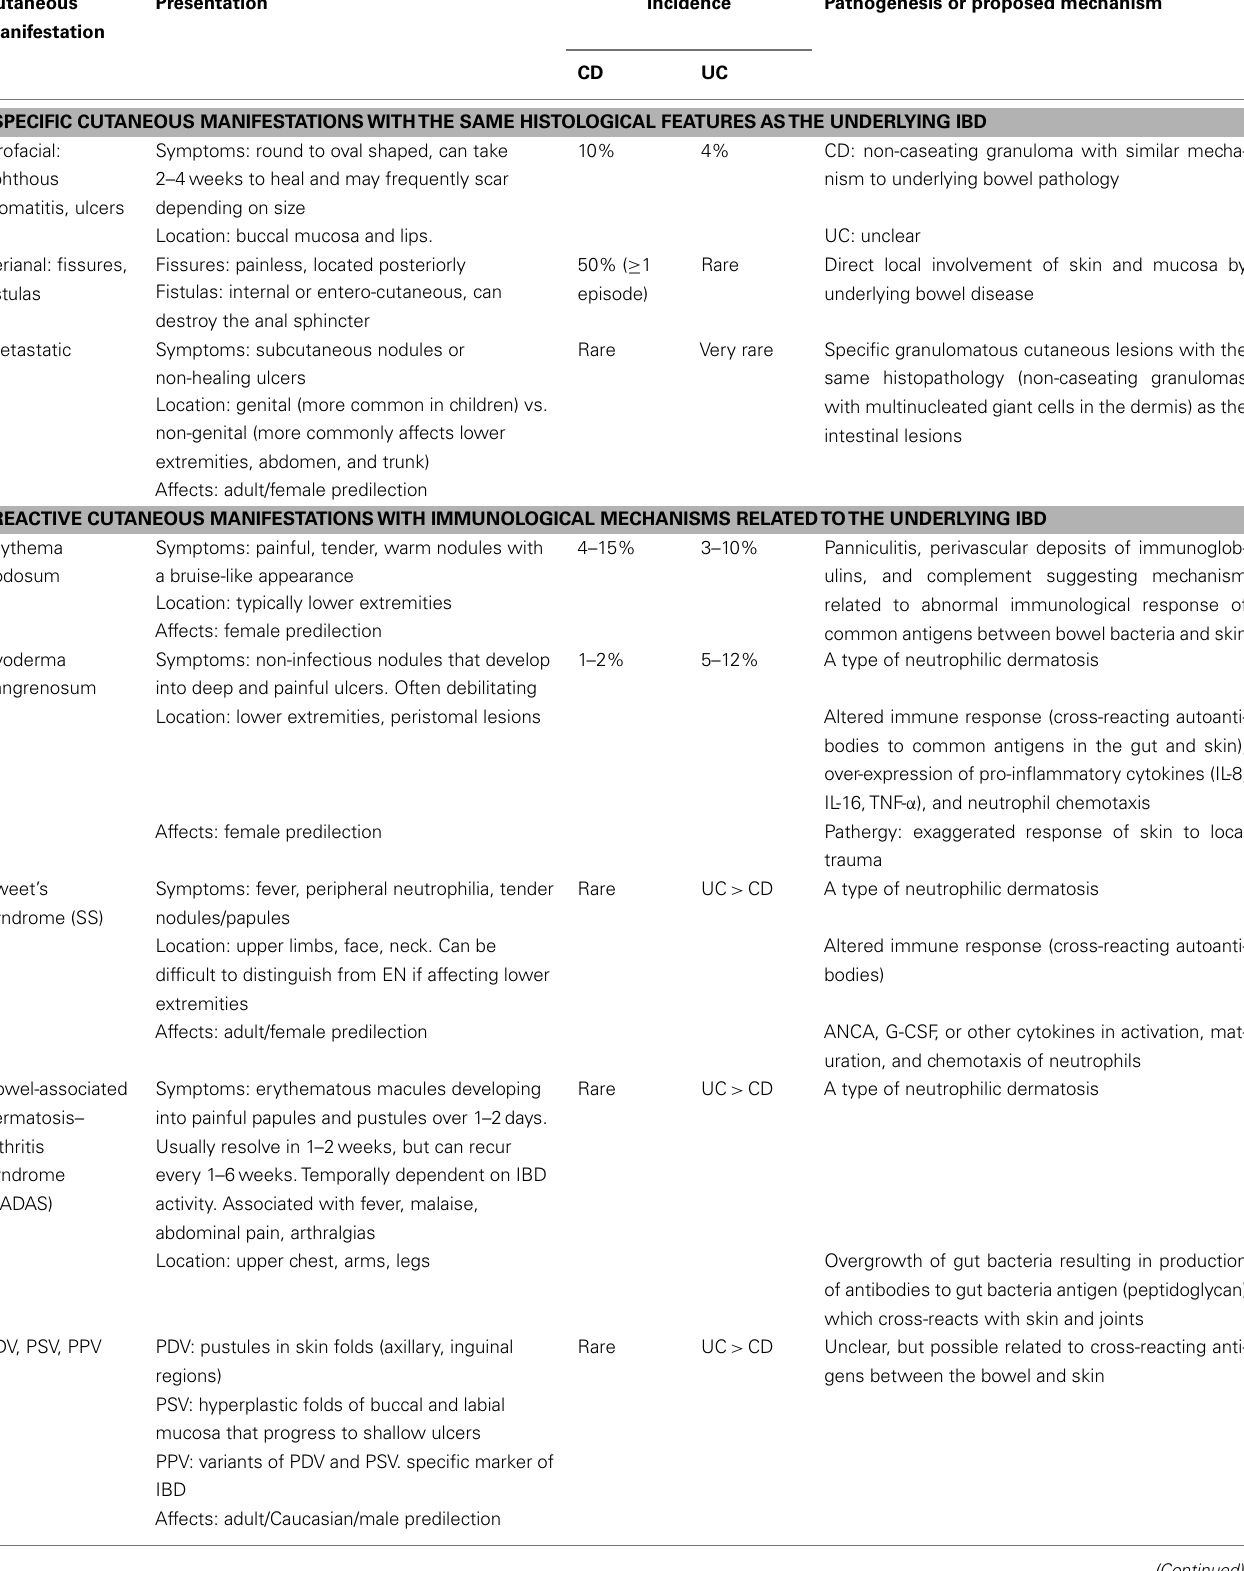
Table 1 | Summary table of cutaneous manifestations of IBD.